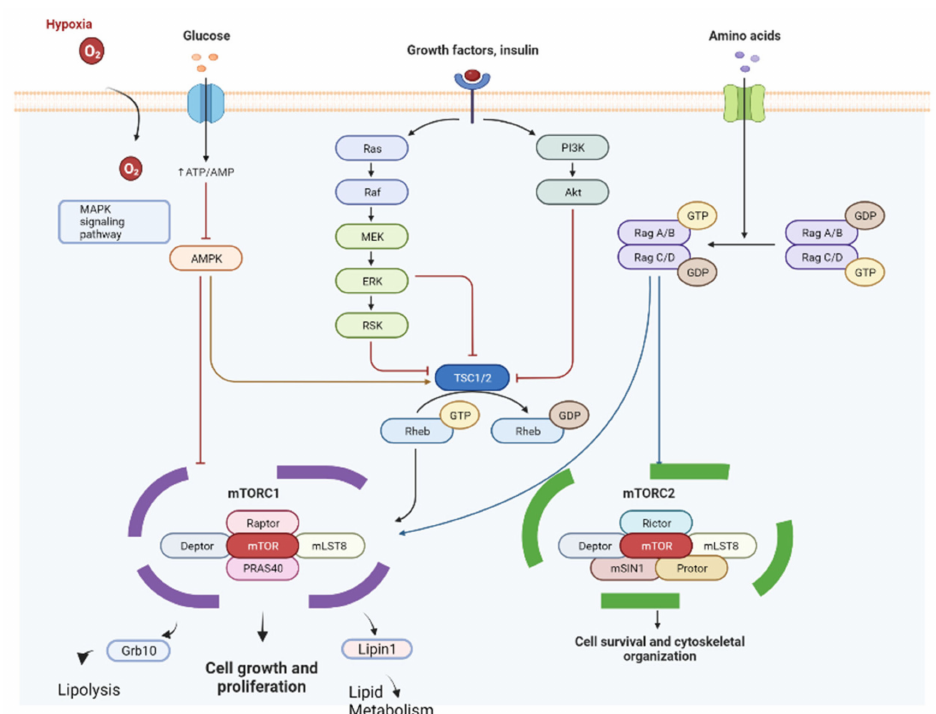
Figure 6. mTOR pathway is involved not only in tumor progression but also in lipid metabolism and lypolysis. Adapted from “mTOR Signaling Pathway”, by BioRender.com (2020). Retrieved from https://app.biorender.com/biorender-templates (accessed on 15 June